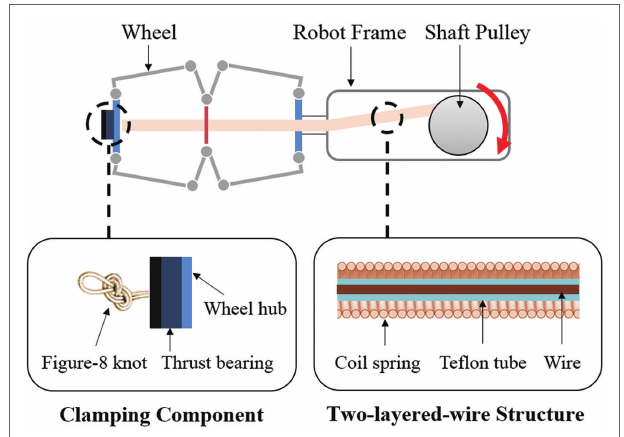
FigUre 4 | schematic diagram of the wheel transformation mechanism . The shaft pulley pulls one side of the wheel, which changes the wheel’s diameter. A thrust bearing prevents the tendon from twisting, and a multi-layered wire structure protects the wheel from being worn out by friction.